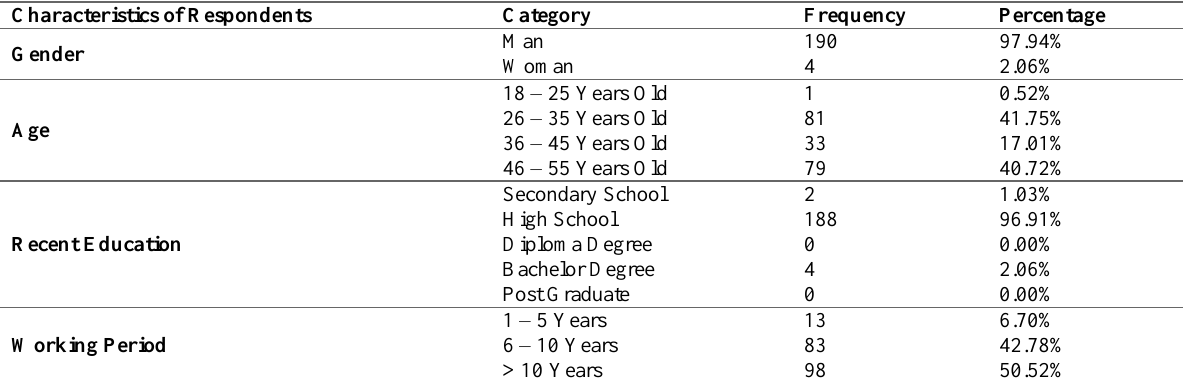
Table 1: Characteristics of Respondents